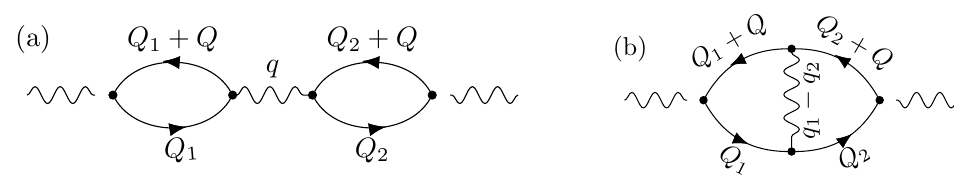
+ Q = ( q + q ,i [ ω + ω ]) . Internal variables 1 1 1